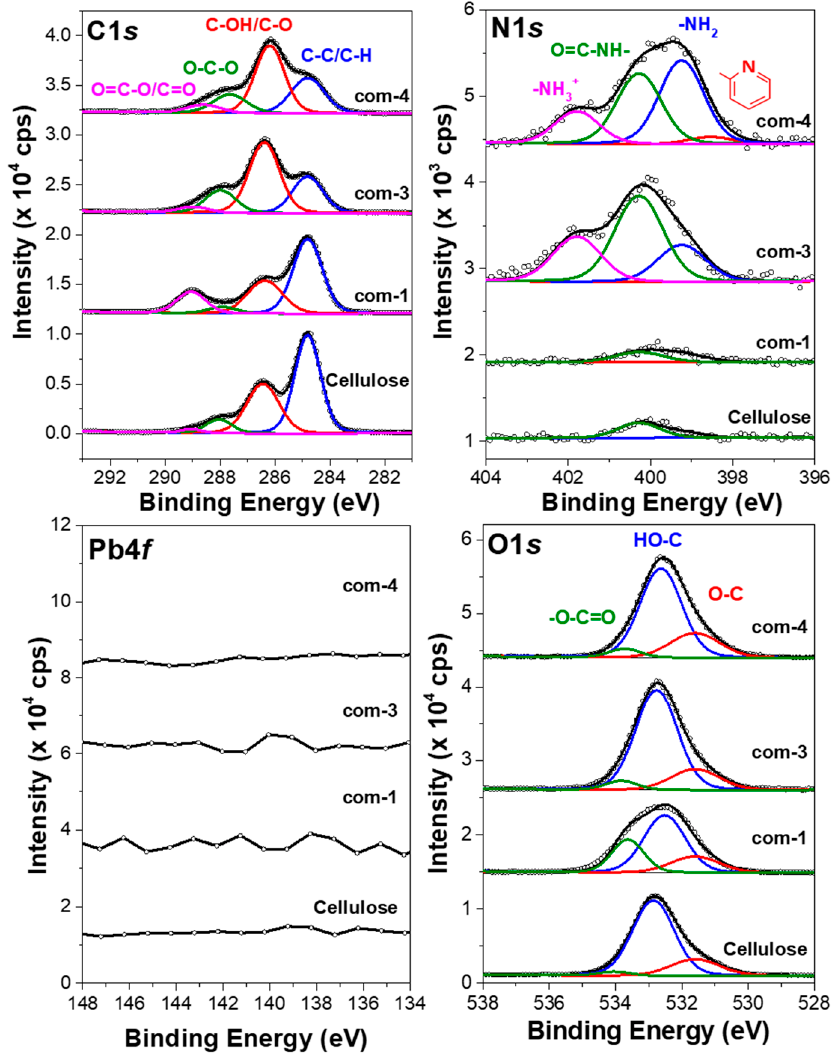
Figure 5. XPS high resolution spectra of core levels of C 1 s , N 1 s , Pb 4 f and O 1s for cellulose, Com-1, Com-3 and Com-4 composites before lead adsorption.